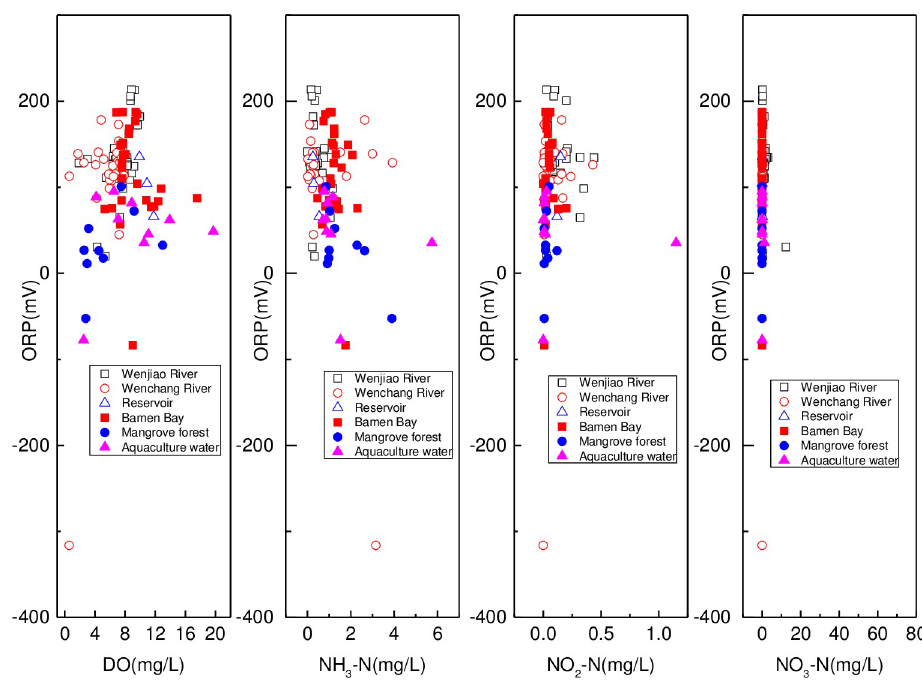
Fig 11. Relationship between ORP and (a) (b) DO, NH 3 –N, (c) NO 2 –N, and (d) NO 3 –N in the Bamen Bay catchment surface